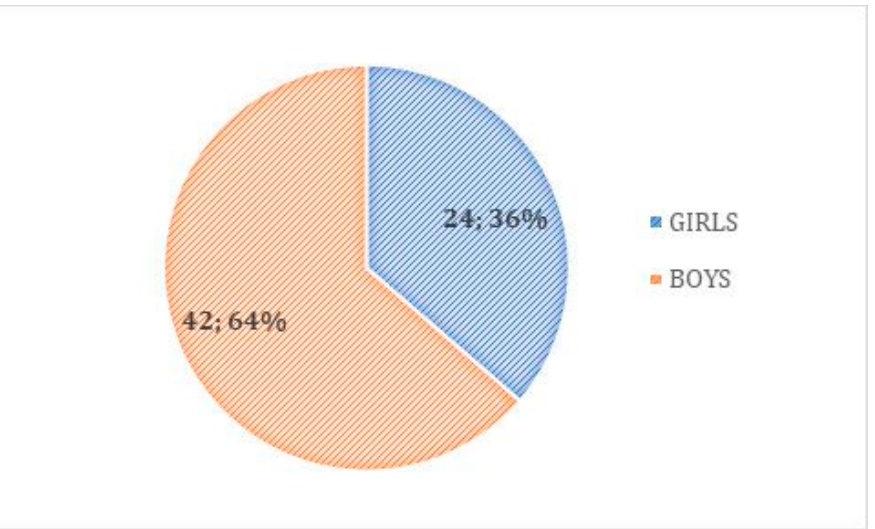
Figure 2. Sex of patients suspected of foreign body aspiration.